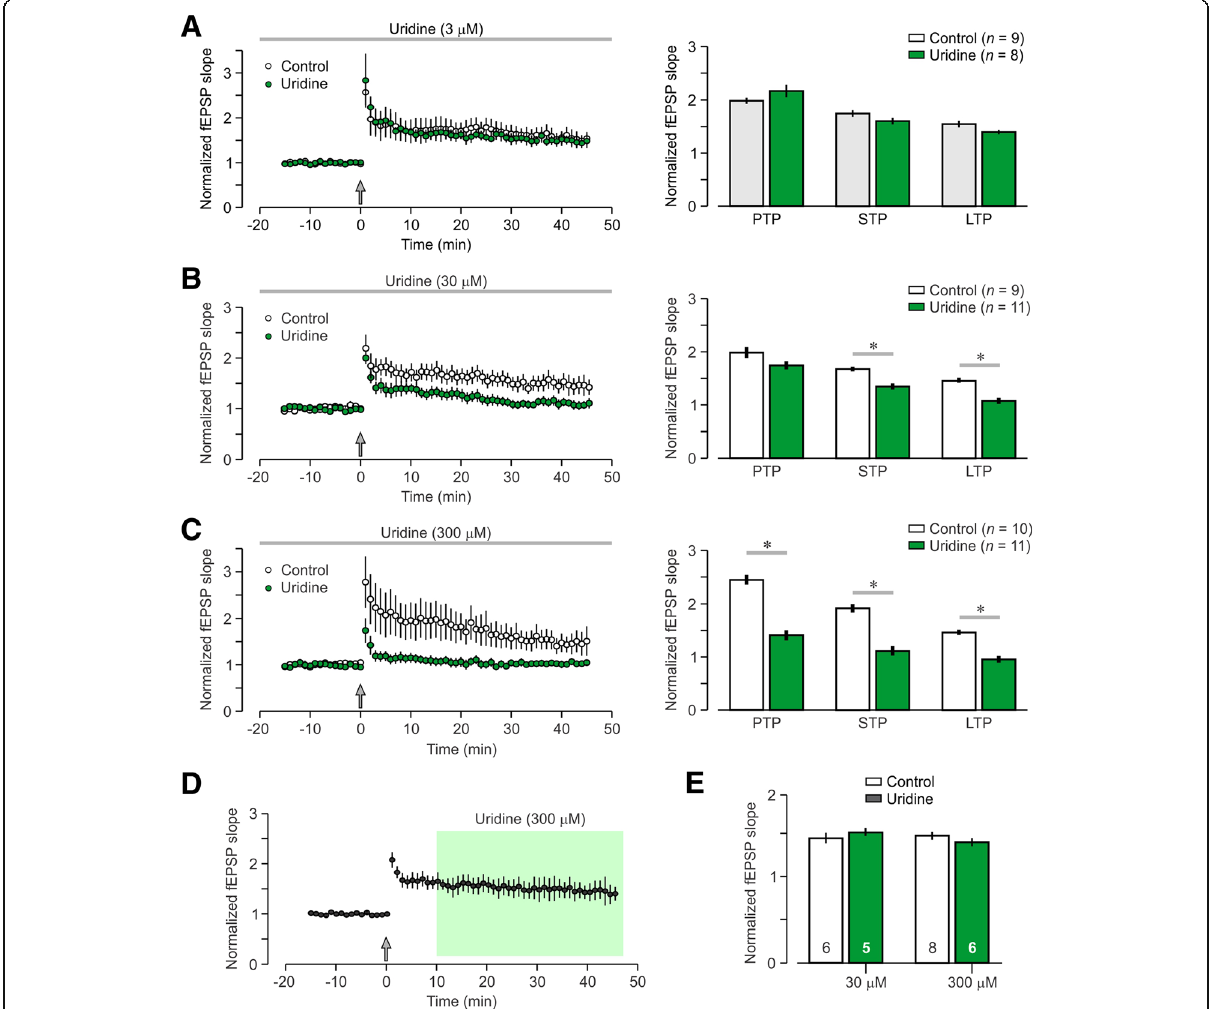
Fig. 3 Concentration-dependent effect of uridine on the induction of long-term potentiation. Brain slices are treated with uridine and fEPSPs are recorded for at least 15 min (baseline period). Then, HFS is delivered and fEPSPs are collected for an additional 45 min. Post-tetanic potentiation (PTP) is measured 1 min post-HFS, short-term potentiation (STP) is calculated 10 – 15 min post-HFS, and long-term potentiation (LTP) is measured 40 – 45 min post-HFS. a Left , graph showing the normalized fEPSP slopes (mean ± SEM) for the uridine (3 μ M) and control groups; the arrow marks HFS. Right , bar graphs show that uridine (3 μ M) does not significantly affect any plasticity time point. b Uridine (30 μ M) has a lowering effect on STP and LTP, but PTP is unchanged; * P < 0.05 (t-test). c Uridine (300 μ M) significantly decreases PTP, STP, and LTP; * P < 0.05 (t-test). d Uridine (300 μ M) has a null effect on LTP expression, when introduced 10 min post-HFS, following the induction of LTP. e Graphs showing the